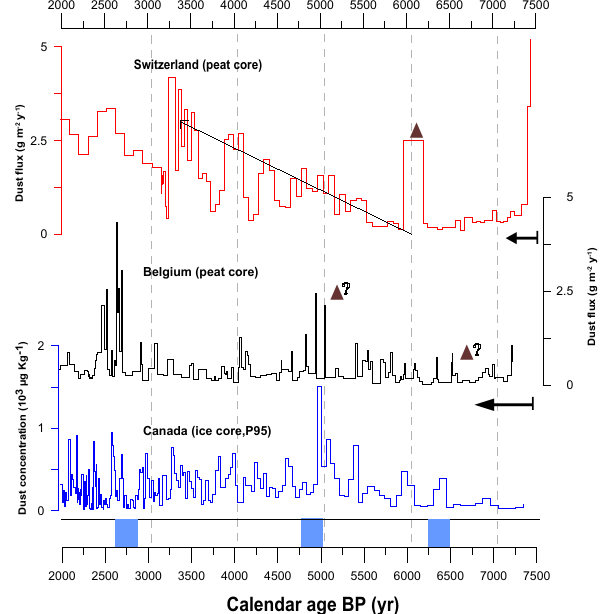
Fig. 10. Comparison of the dust flux measured in the Misten bog (black line, this study) with the dust flux (gm − 2 yr − 1 ) obtained from a Swiss peat core (green line, Le Roux et al., 2012) and with the dust concentration (10 3 µgkg − 1 ) measured in a Canadian ice core from Zdanowicz et al. (2000). The three dark-blue bars show the cold events described in Wanner et al. (2011). Brown tri- angles represent the volcanic events. Black arrows underline the minerotrophic peat